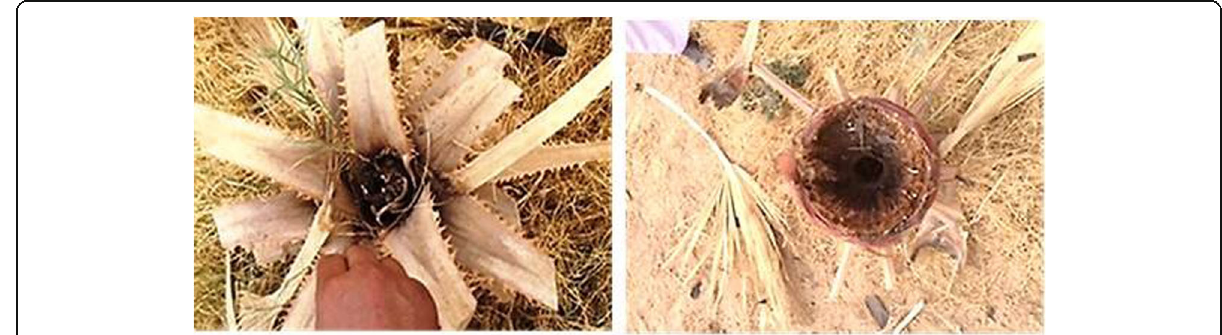
Fig. 3 The late stage of the terminal bud rot disease of Washingtonia robusta tree showing complete decaying of the terminal bud (left) and total disintegration of tissues in the base of the tree leaving a black hallow cavity in the base of the dead